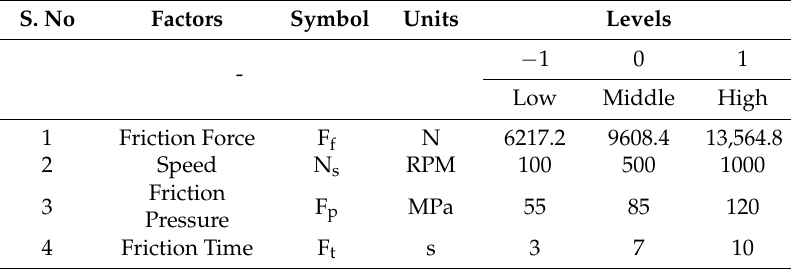
Table 3. Friction welding factors and their design levels.